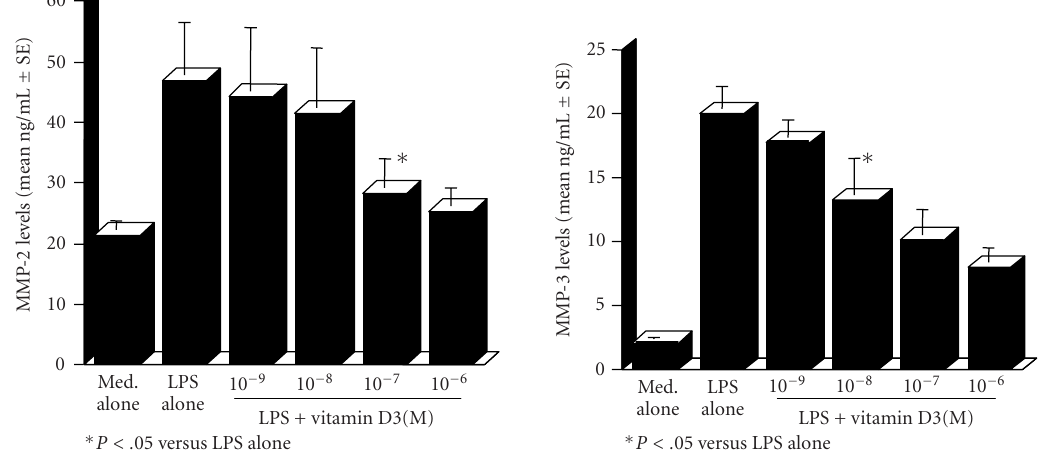
Figure 1. Suppressive activity of vitamin D3 on MMP-2 and MMP-3 production from keratinocytes in vitro. Keratinocytes (2 . 5 × 10 5 cells/mL) derived from cholesteatoma tissues were stimulated with 100 µ g/mL lipopolysaccharide (LPS) in the presence of various concentrations of vitamin D3 for 24 hours. MMP-2 levels in culture supernatants were examined by ELISA. Each set of data was expressed as the mean ng/mL ± SEM of five di ff erent subjects.